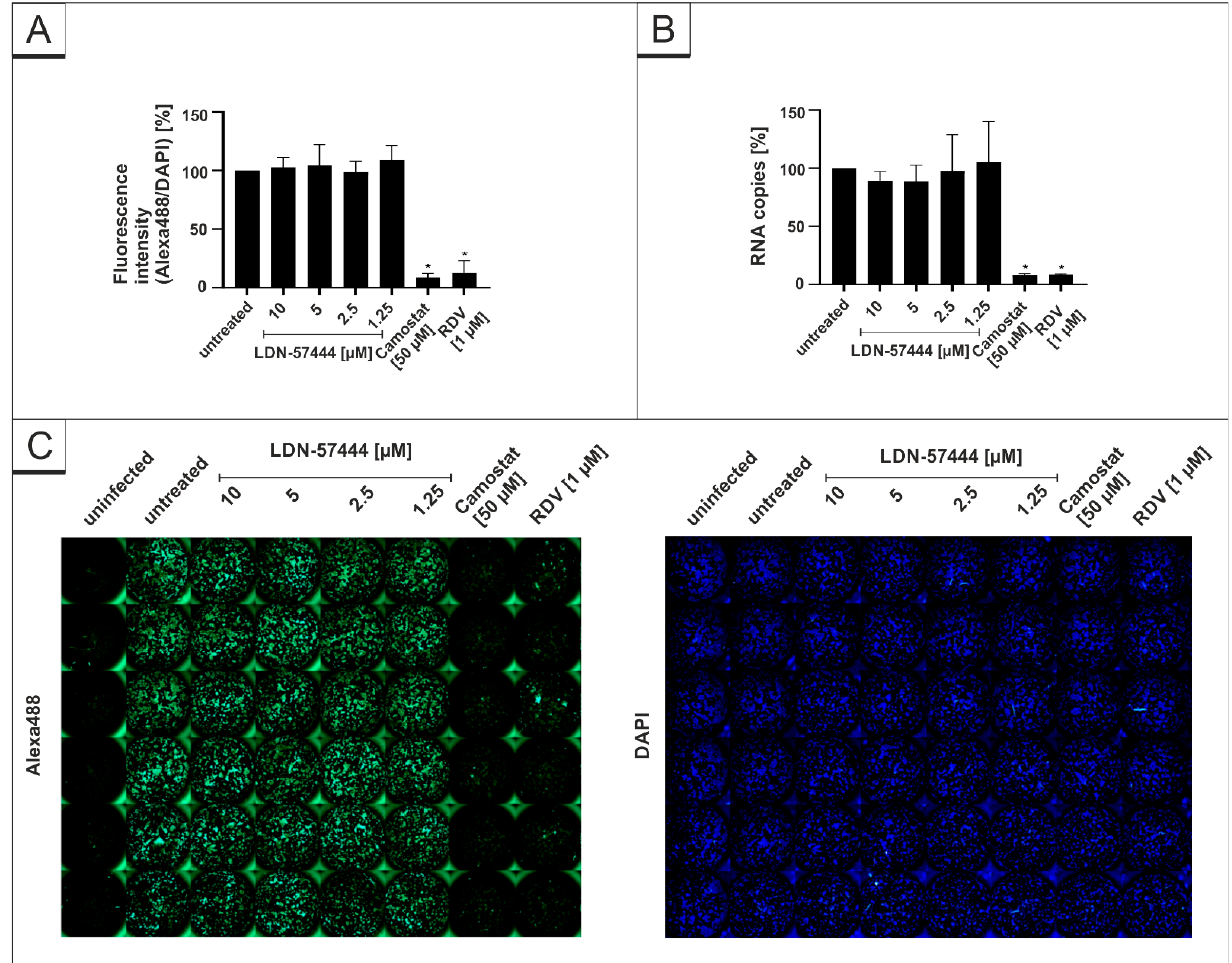
Figure 5. LDN-54777 does not inhibit SARS-CoV-2 replication in Calu-3 cells. Quantitative analysis of fluorescence microscopy ( A ), qRT-PCR of cell culture supernatants ( B ) and representative images of fluorescence staining ( C ) 30 h post infection. Cells were analyzed via microscopy using anti-SARS-CoV-2 NP-antibody. Bars show mean values of three independent experiments ± standard deviation. Statistical analysis was performed using a multiple comparison Kruskal–Wallis test (Anova) followed by Dunn’s post hoc test (* p < 0.05).